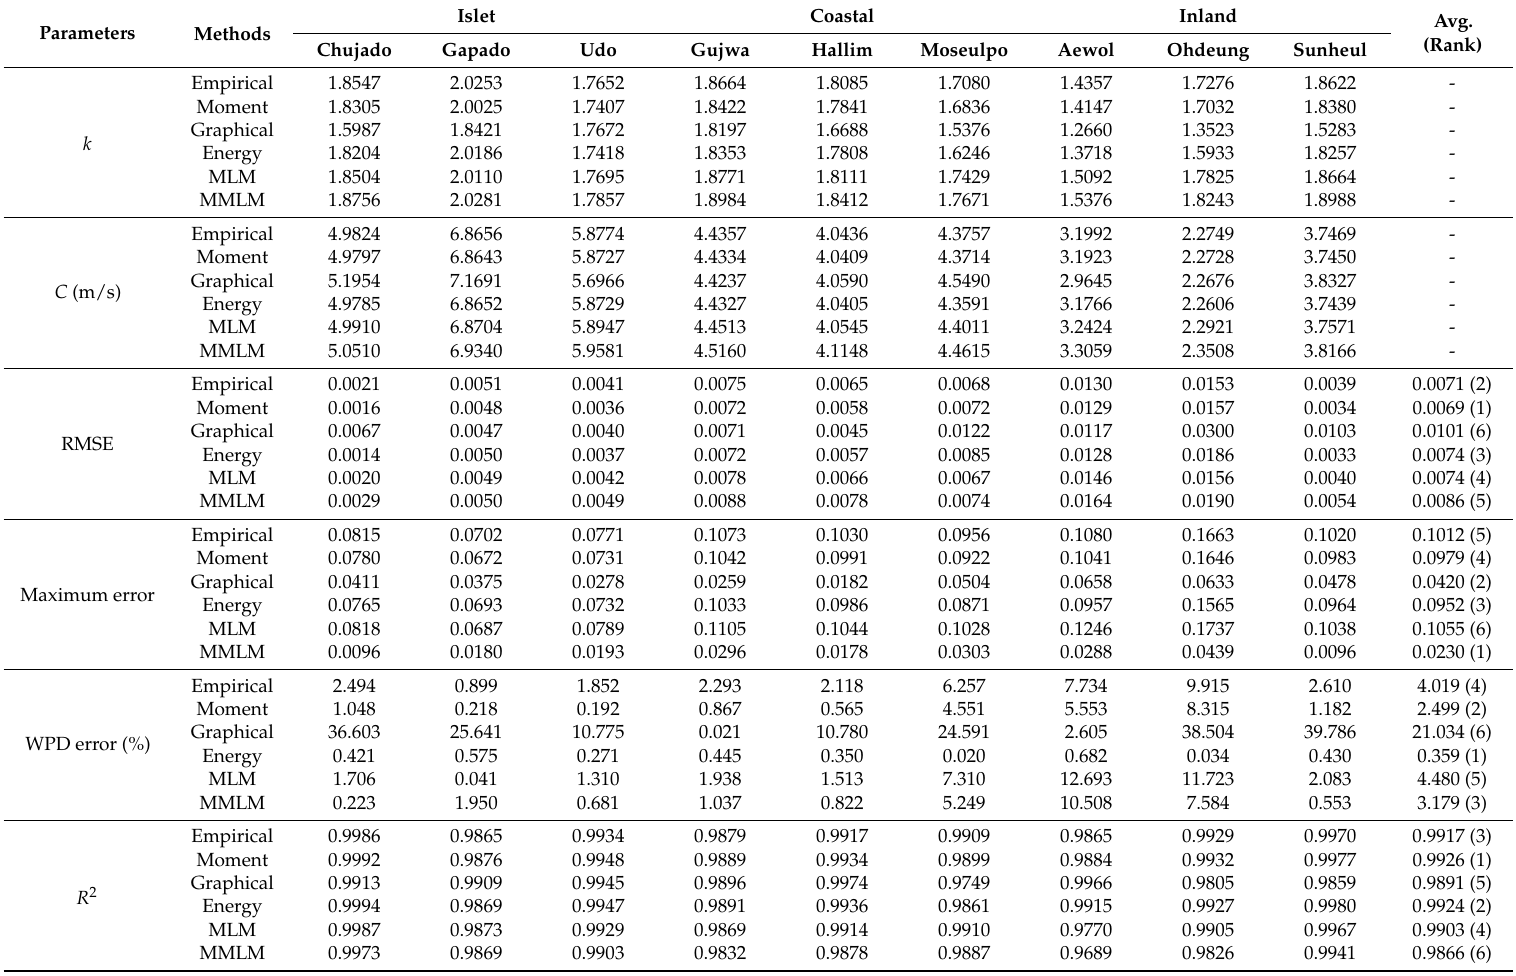
Table 6. The estimated Weibull parameters and the results of the accuracy